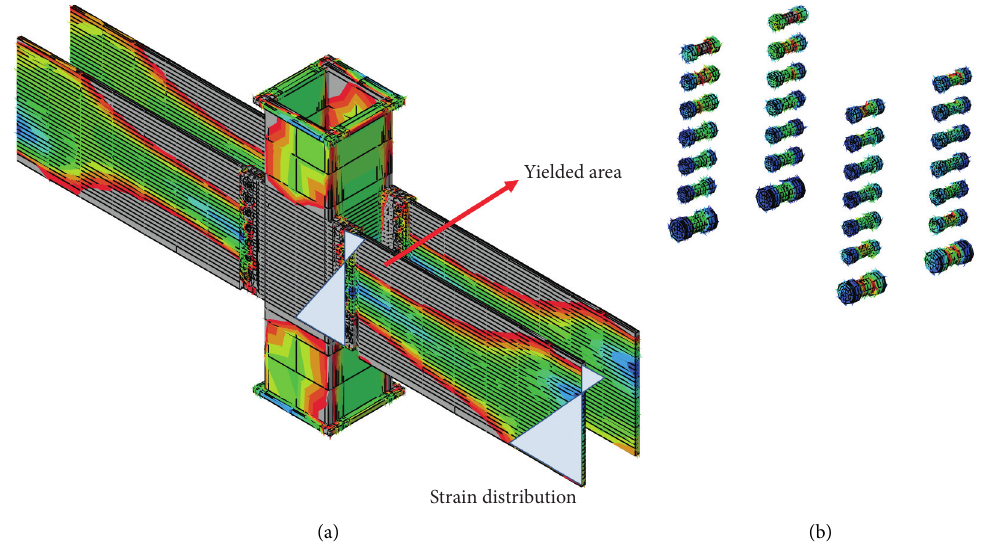
Figure 22: Stress distribution. (a) Steel plates. (b) Connection bolts. Table 4: Stress distribution and resultant force